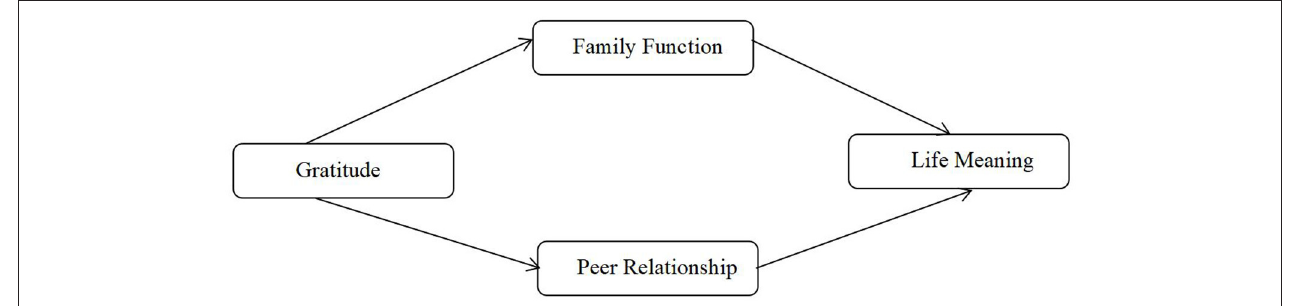
FIGURE 1 | Theoretical model of the